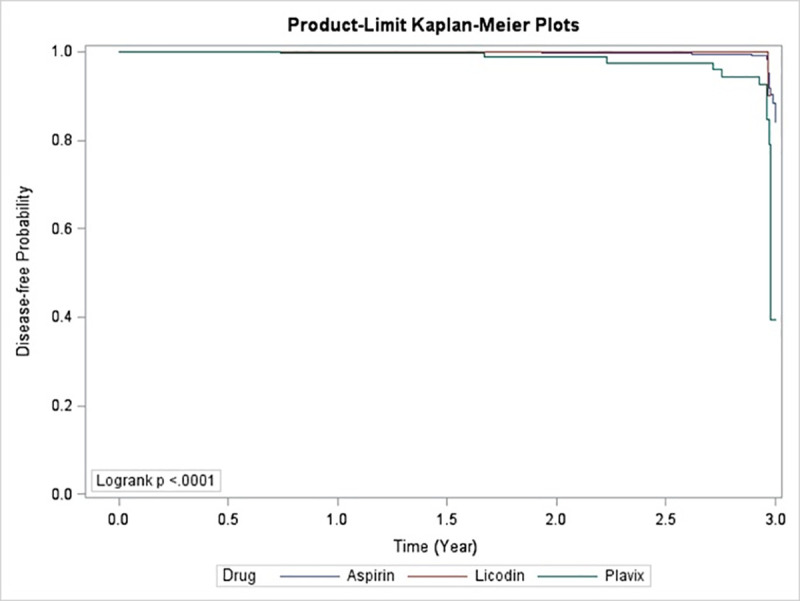
Kalpan–Meier curve for recurrent stroke.Licodin: ticlopidine, Plavix: clopidogrel.